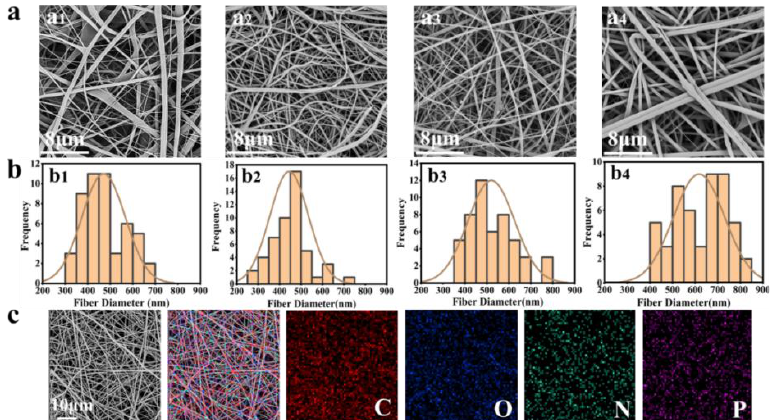
Figure 3. Morphology and characterization of the electrospun membranes. ( a , b ) SEM images (10,000 × ) and diameter distribution of 50 fibers in electrospun membranes of different components.